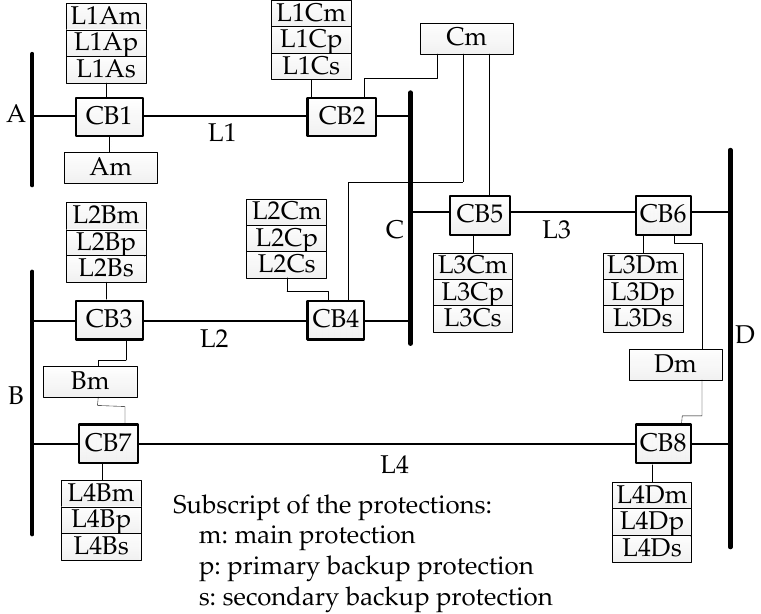
Figure 1. The sample power system and its protection configuration.